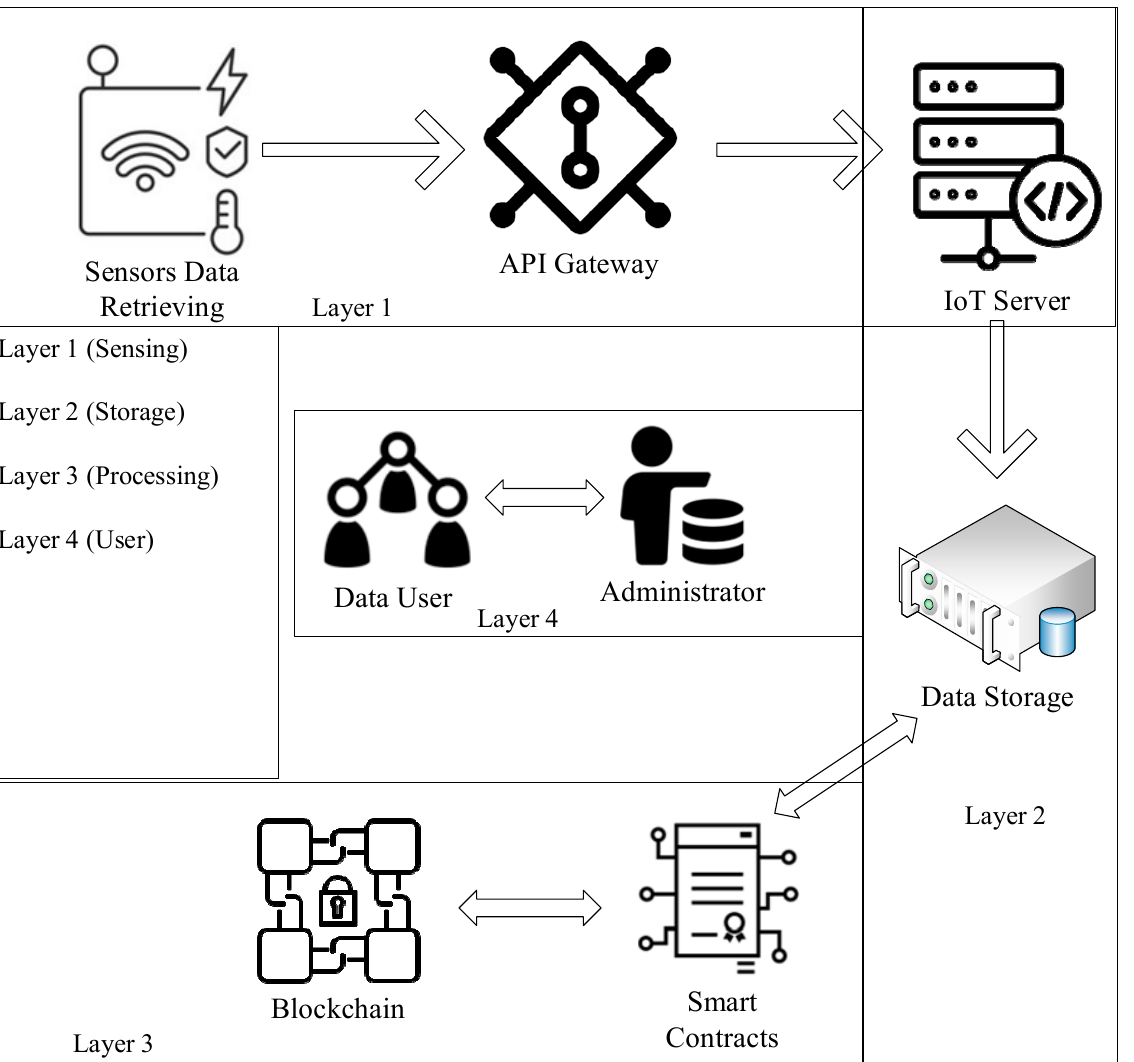
Figure 3. Overview of the proposed solution.